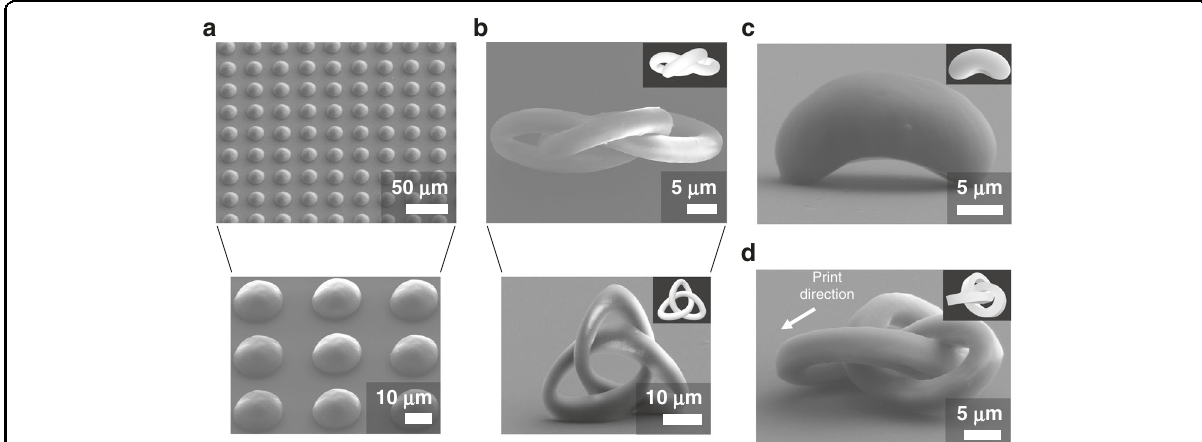
Fig. 5 3D structures printed using continuous, layer-by-layer projection two-photon lithography system. All structures were fabricated with a 100 µm s − 1 stage speed along the vertical ( z ) direction. Computer models used for printing are included as fi gure insets for complex structures. a Curved surfaces demonstrated through fabrication of array of hemispheres comparable to microlens arrays. 1 mm 2 area of coverage in about 6.2 min with 1 mm s − 1 stage travel between each hemisphere and laser intensity of 132 W cm − 2 . b Complex trefoil knot structure with a circular cross- section viewed from top (upper image) and 75 ˚ tilt angle from normal (lower image) printed with 144 W cm − 2 laser intensity. c Chicago ’ s Cloud Gate sculpture printed with 120 W cm − 2 laser intensity demonstrating largescale curved features. d Trefoil knot with square cross-section printed with 144 W cm − 2 laser intensity. The structure fell over during the development process, therefore the print direction is